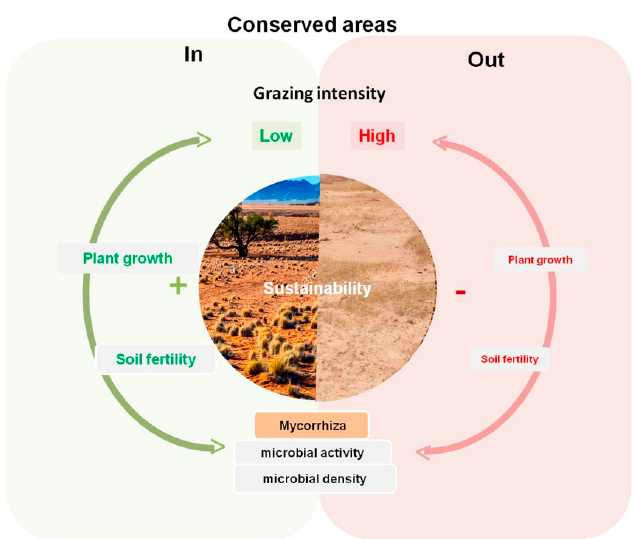
Figure 8. Schematic representation of the AMF effects on soil fertility and ecosystem stability under lightly grazed sites (inside the protected areas) versus intensively grazed sites (outside the protected areas), for arid Mediterranean ecosystems.